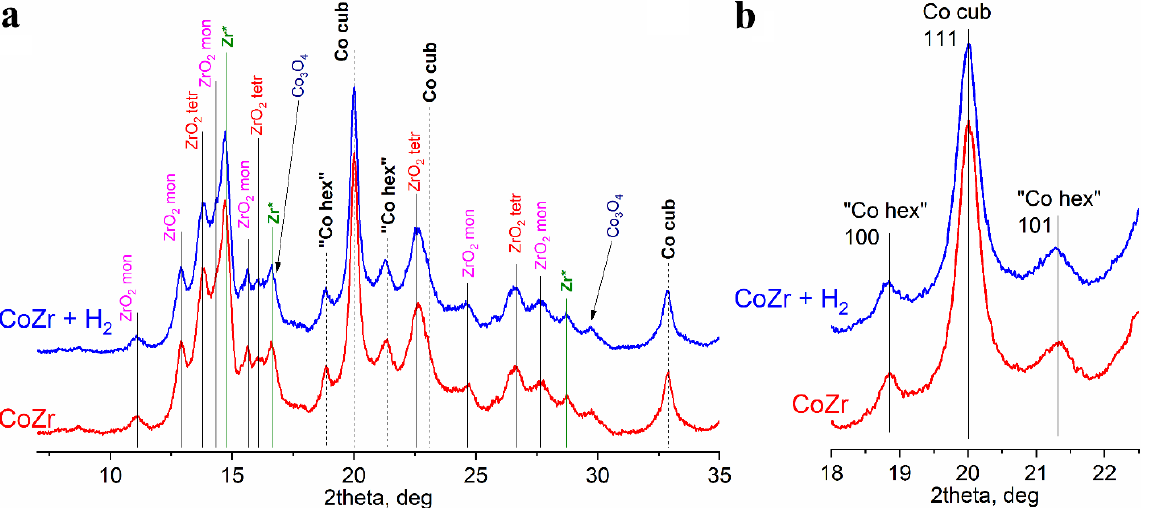
Figure 4. ( a ) XRD patterns of the mechanically alloyed (red) and subsequently hydrogen treated (blue) mixtures of Co and Zr powders, shifted along the y-axis; ( b ) fragments of the XRD diffraction patterns showing the main peaks related to Co with fcc structure (Co cub) and Co with hcp packing (“Co